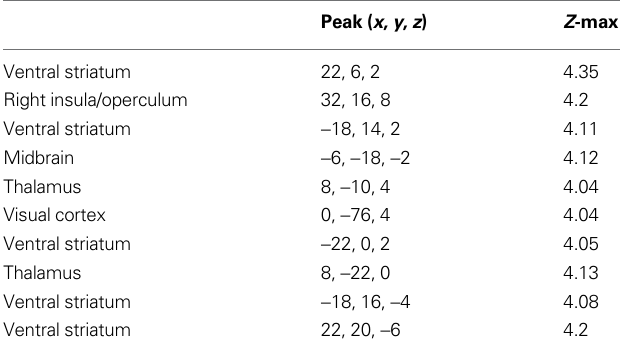
Table 4 | Charity, Lose $4 > Lose